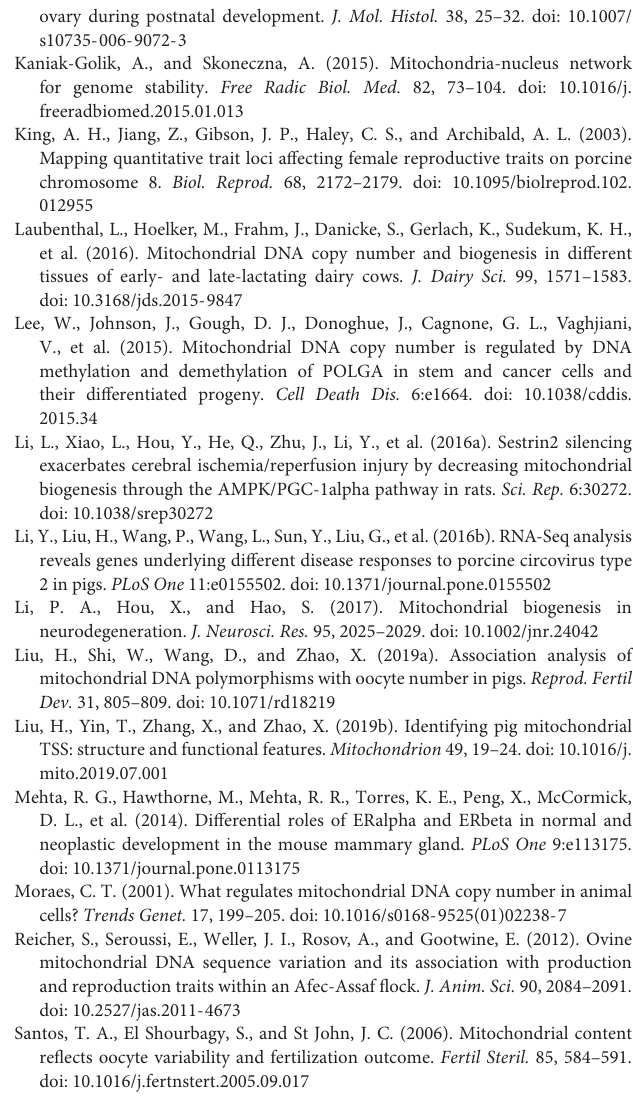
Supplementary Table 2 | Polymorphic sites detected among mitotypes. Supplementary Table 3 | Polymorphic sites for identifying